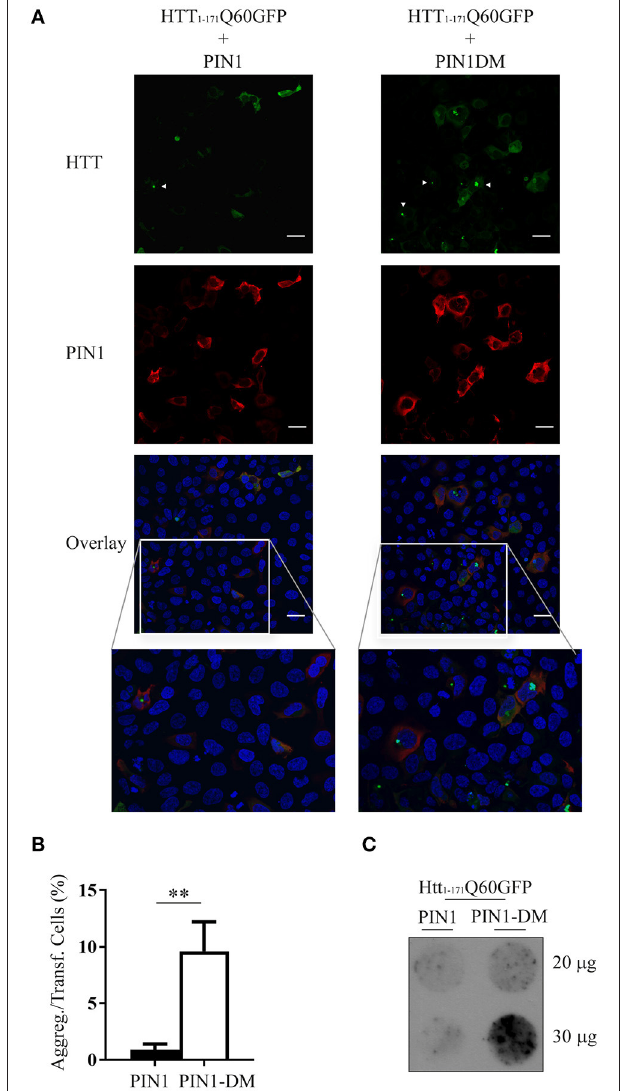
HEK293 cells were co-transfected with htt 1 – 171 Q60GFP and HA-PIN1 or HA-PIN1DM. Cells were harvested for analysis 48h after transfection. (A) Representative immunofluorescent images of co-transfected cells immunostained for PIN1 (anti-HA, red) and counterstained with DAPI (blue). GFP signal (green) represents HTT. Scale bar, 20 µ m. (B) mHTT aggregates amount quantified from immunostained cells as shown in (A) . (C) Representative filter retardation assay of SDS-insoluble aggregates extracted from co-transfected cells. For data on transfection efficiency and total numbers of cells counted see Supplementary Table 2 column “Figure 2.” Data are the mean ± SEM from 4 independent experiments using 2 different batches of cells. ** P < 0.01. Asterisk indicates the statistically significant difference in the level of aggregates. Arrowhead indicates